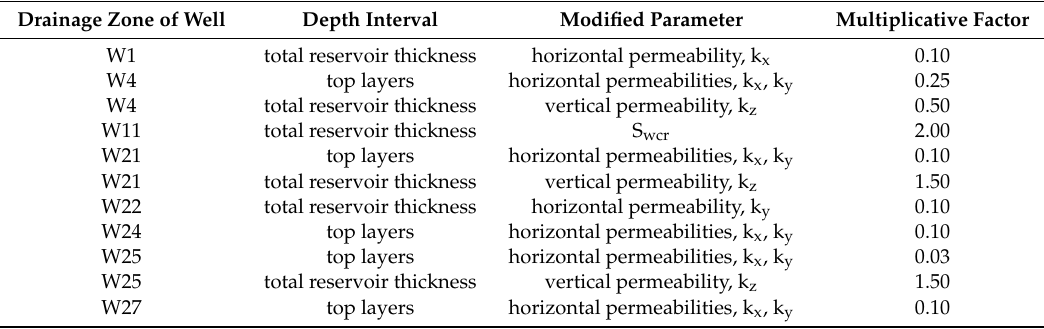
Table 3. Modifications of model parameters from the calibration